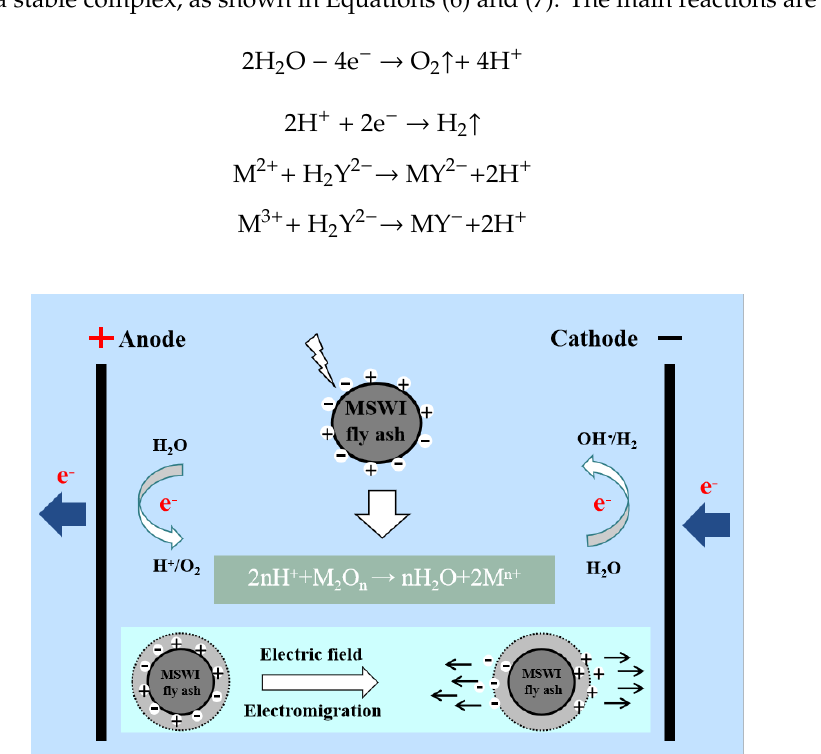
Figure 11. Electric field intensifies heavy metal in MSWI fly ash removal process.